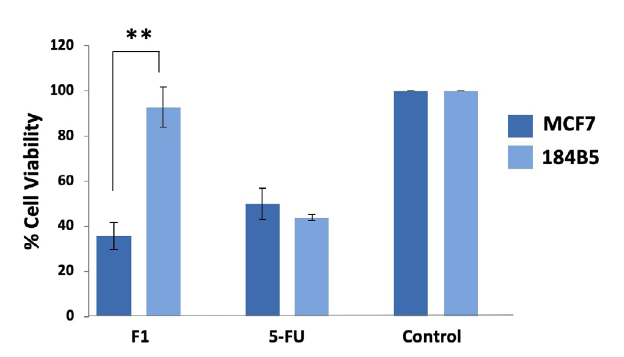
Figure 4. Cell viability of human breast cell lines, MCF7 (cancerous) and 184B5 (normal) after 72-hour treatment with 20 µg of Fraction 1 (F1,